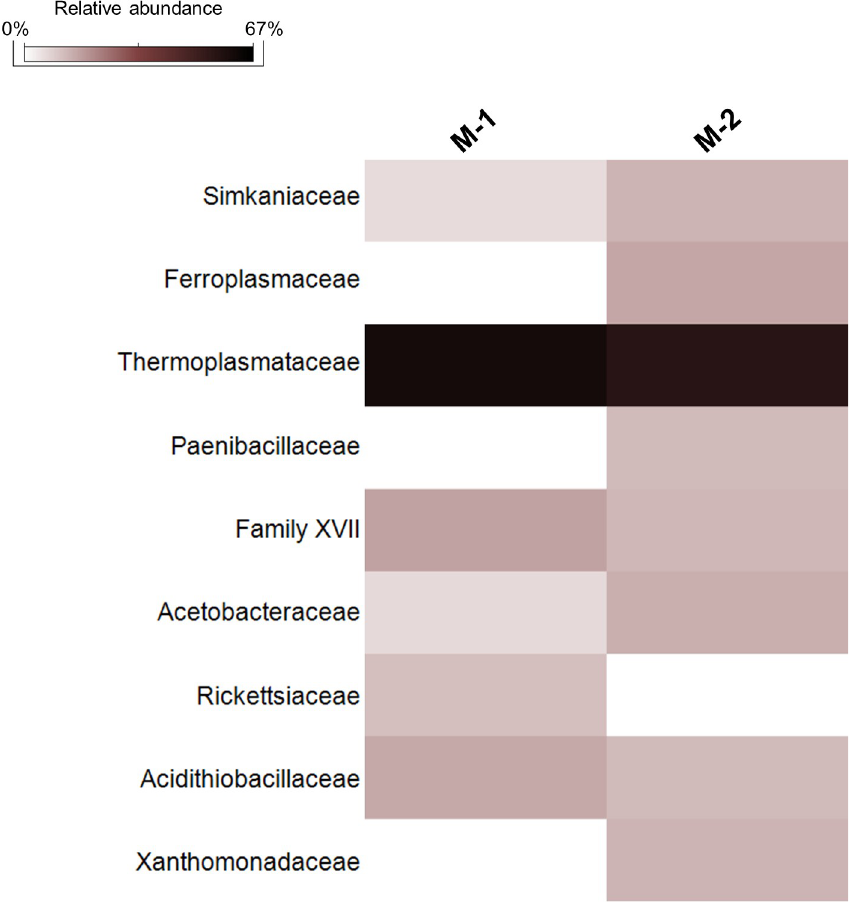
Fig 12. Heatmap showing the abundance of the microbial families present in Fetida Cave moonmilk deposits. Only those families with a relative abundance > 2% are shown.